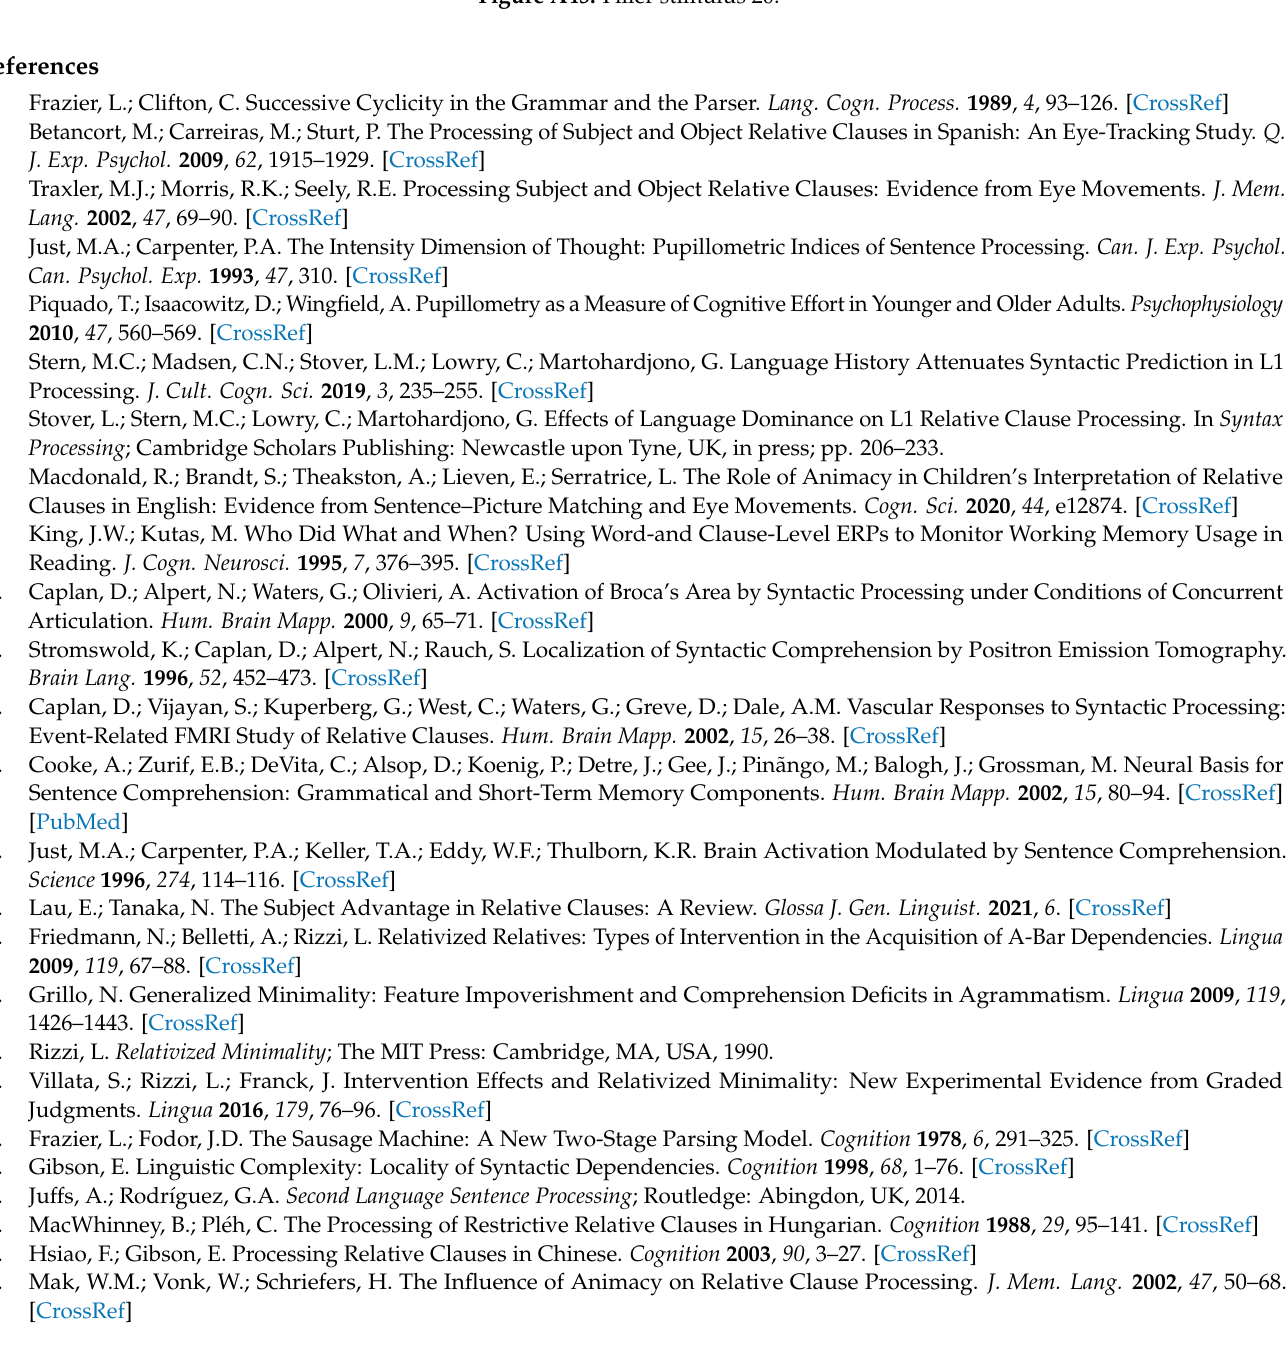
Figure A45. Filler stimulus 20.